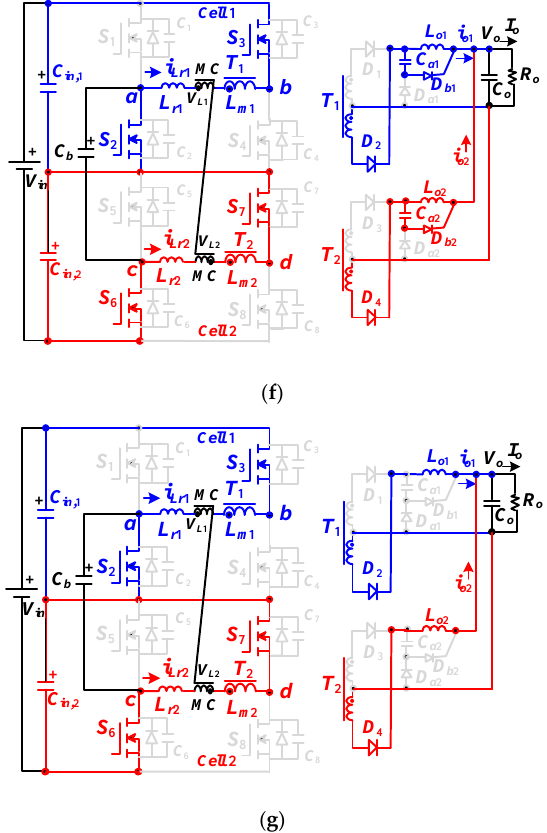
Figure 4. Equivalent circuits in first seven steps ( a ) step 1, ( b ) step 2, ( c ) step 3, ( d ) step 4, ( e ) step 5, ( f ) step 6, ( g ) step 7.